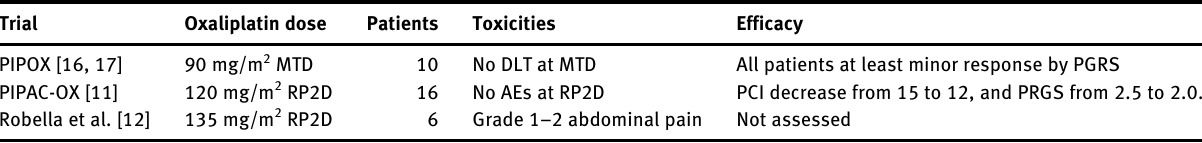
Table  : Dose fi nding Phase I studies of